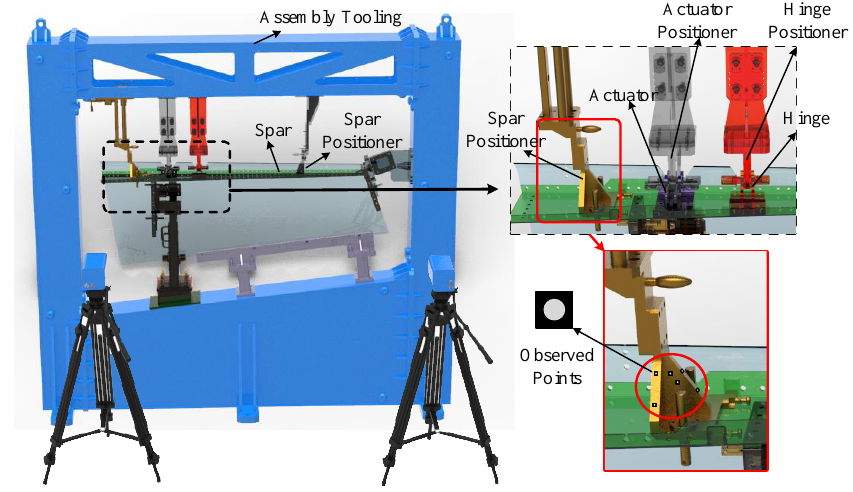
Figure 1. Monitoring process based on cameras.